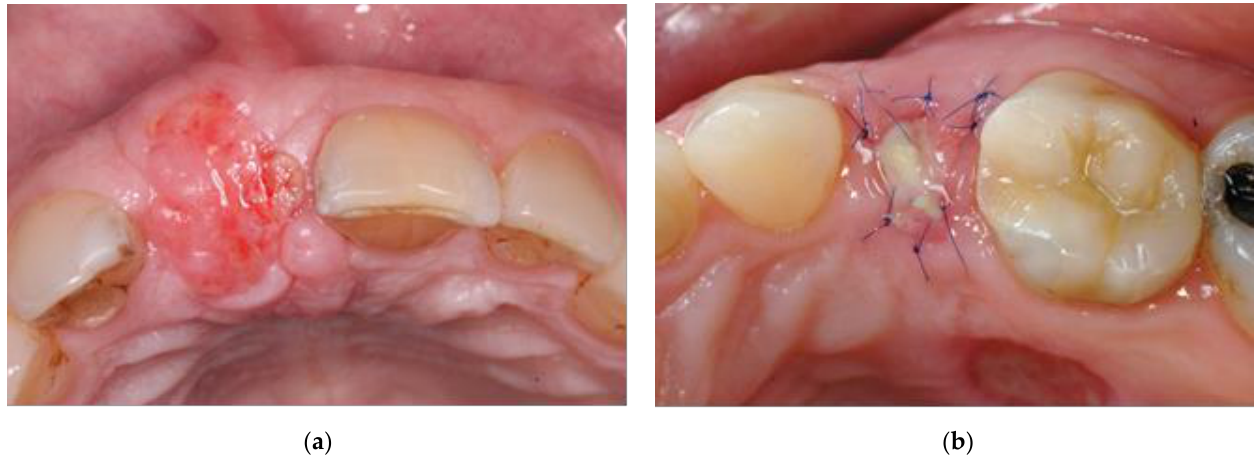
Figure 2. T1 images: a vital ( a ) and a partially vital graft ( b ).